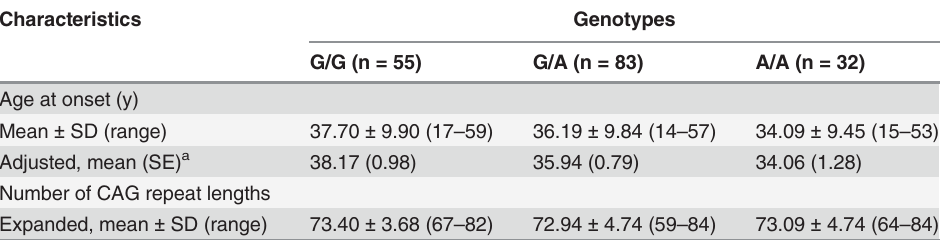
Table 3. Age at onset in SCA3/MJD patients with rs709930.